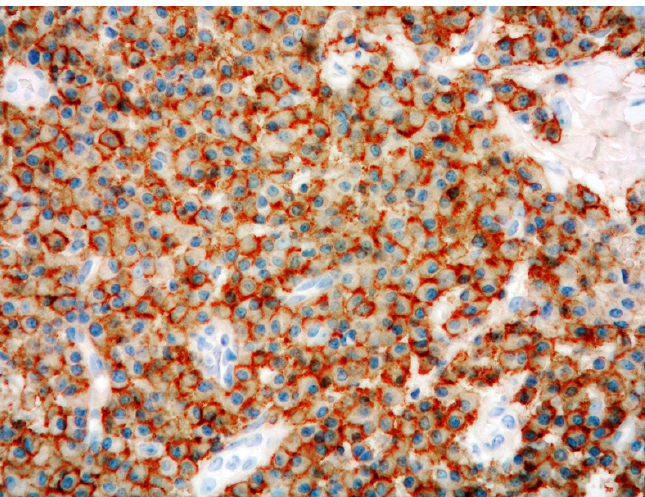
Figure 3. High-power view of PCMZL, plasmacytic variant: CD138 stain highlighting the plasma cell infiltrate (immunostaining, magnification 200×; original image from Prof. S.A.).